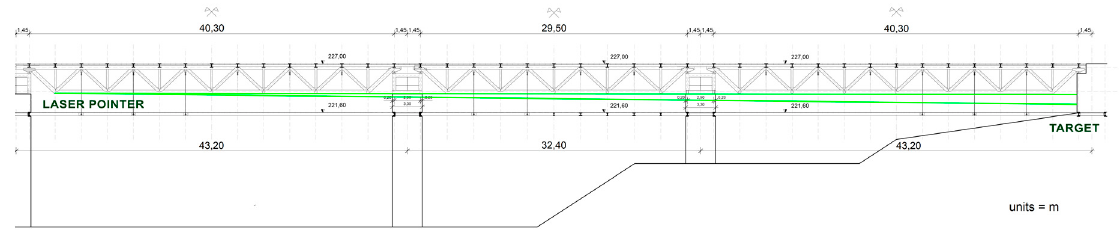
Figure 5. The layout of the test.